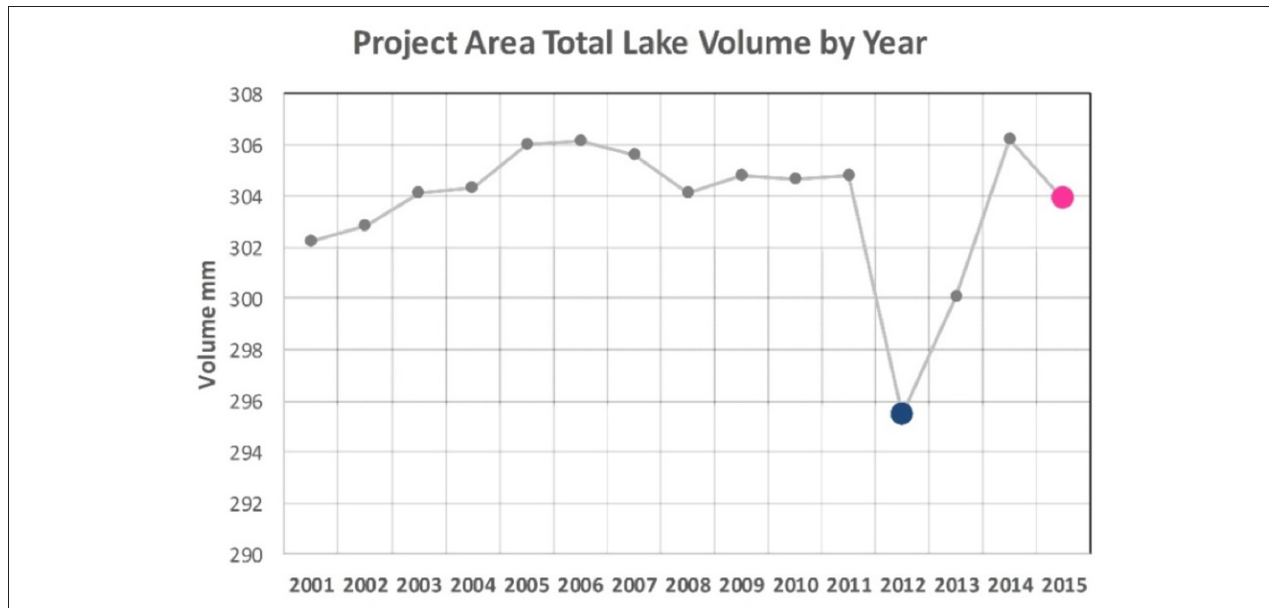
FIGURE 7 | The temporal variation in total water stored in the lakes of the region. Note the sharp drop in volume in the year 2011–2012, and the gradual recovery in following 2